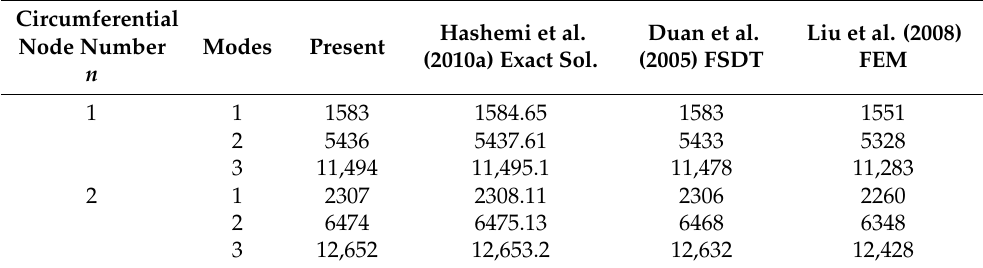
(cid:113) I 0 with A 11